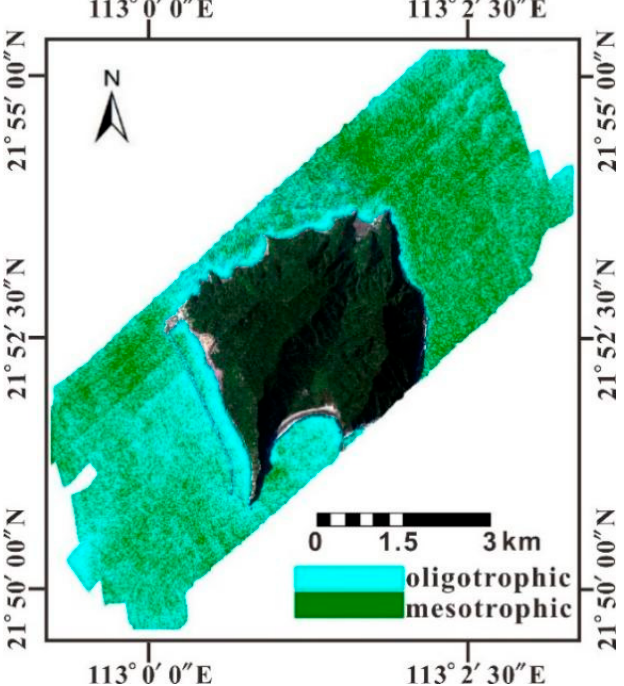
Figure 12. Image depicting the eutrophication status of the sea area around Dajin Island. Although no obvious correlation between SSC and Chl-a is observed in the study area, SSC in the Pearl River Estuary indicated an inverse correlation with Chl-a in the Huangmaohai Sea. Thus, the low Chl-a in the sea area around Dajin Island may be induced by the high SSC with low transparency. In addition, the Huangmao Sea is an estuary with weak runoff but very strong reciprocating tidal flow. The measured maximum average flow velocity of the high tide flowing to the northeast is 1.24 m/s, and the maximum flow velocity is supposed to be 1.01 m/s at the surface [49]. The turbulent hydrodynamical environment may result in low biomass, even though nutrient availability is high. Considering the high Chl-a concentration in the outer estuary inversion by MODIS/Chl-a image, it should be anticipated that the abundant nutrients carried by runoff from land source and released from aquaculture activities will incur algal blooms under suitable conditions. Therefore, eutrophication may be underestimated based on the Chl-a. The study area is deduced to be in mesotrophic